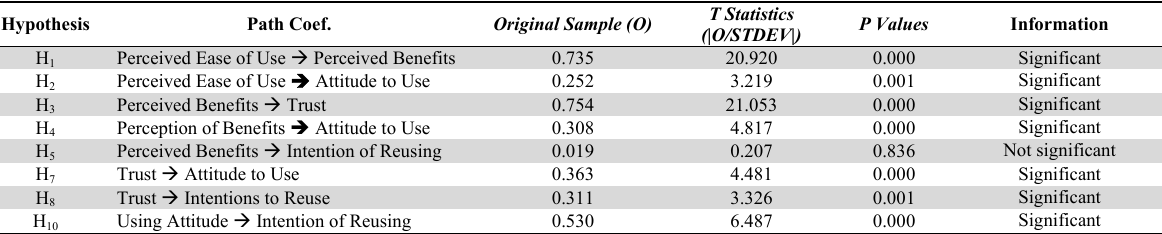
Validation Test Path